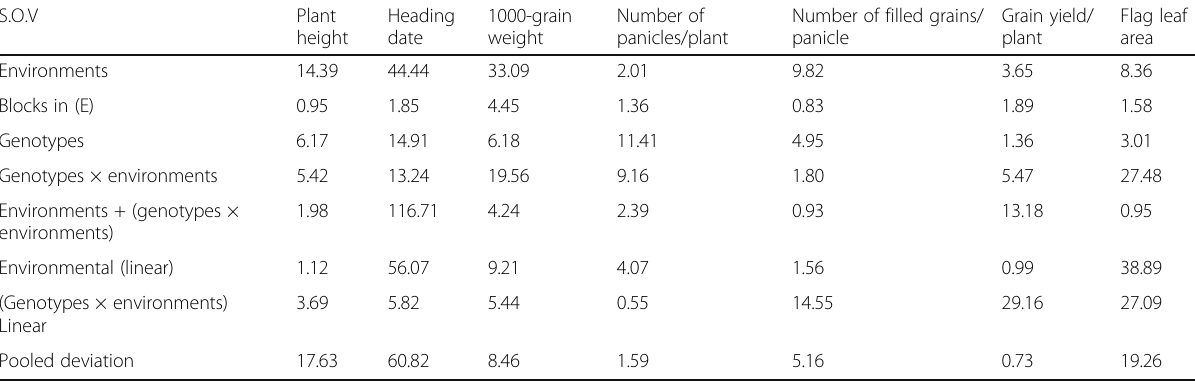
Table 3 F-ratio values for the components of stability